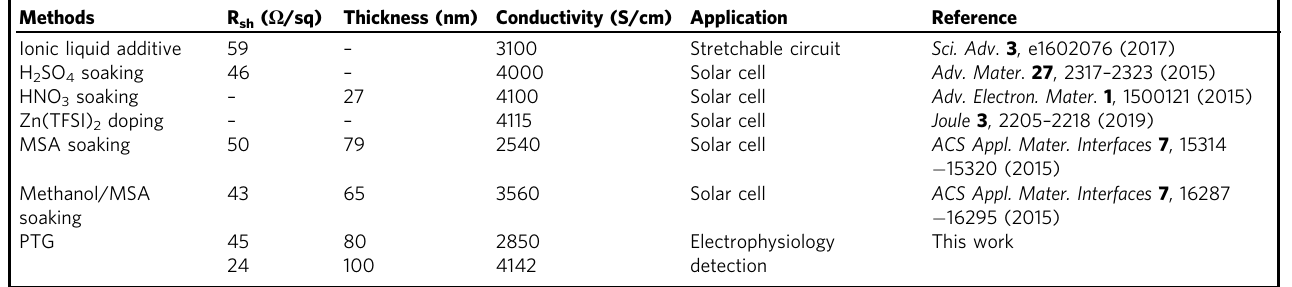
Table 1 Sheet resistance (R sh ), Thickness and Conductivity of different PEDOT:PSS fi lm. Methods